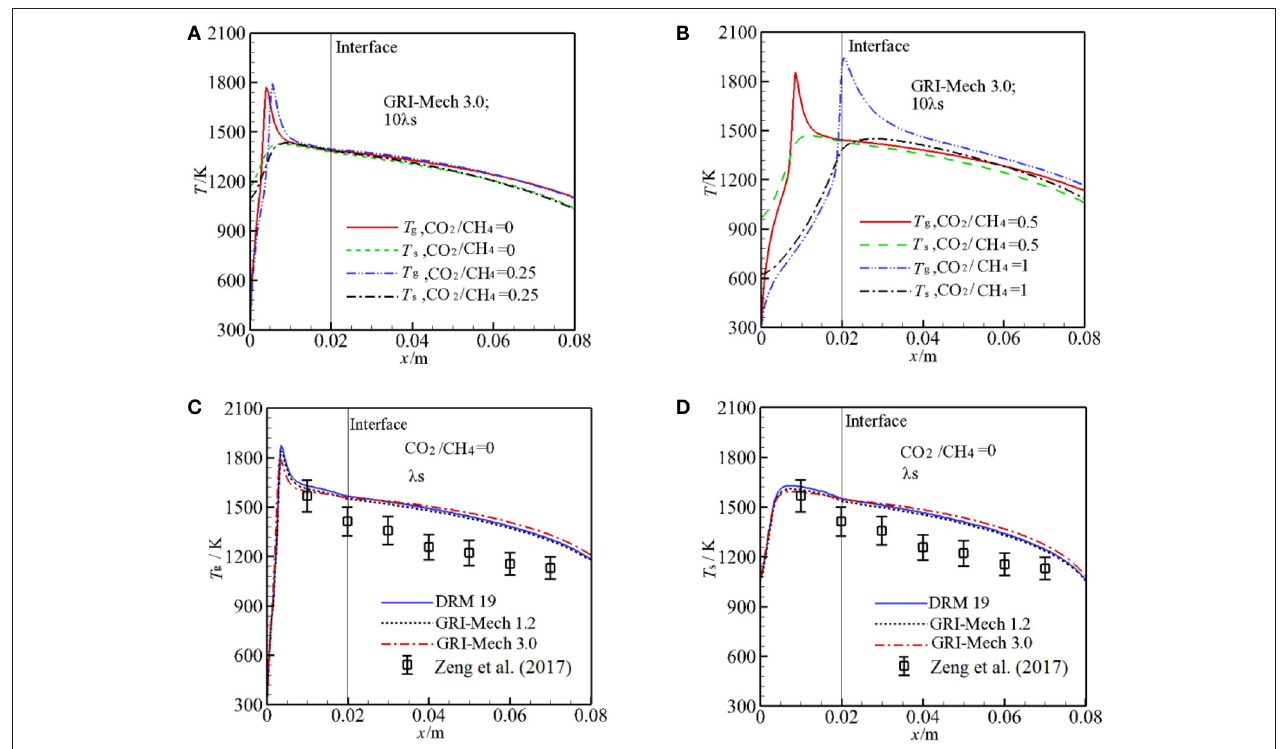
FIGURE 2 | Temperature distributions along the centerline of the burner for different kinetics. (A) Gas, solid temperature for molar ratio of CO 2 /CH 4 = 0, 0.25, and 10 times of thermal conductivity of packed bed with GRI-Mech 3.0; (B) Gas, solid temperature for molar ratio of CO 2 /CH 4 = 0.5, 1, and 10 times of thermal conductivity of packed bed with GRI-Mech 3.0; (C) Gas temperature for molar ratio of CO 2 /CH 4 = 0 with three different mechanisms; (D) Solid temperature for molar ratio of CO 2 /CH 4 = 0 with three different